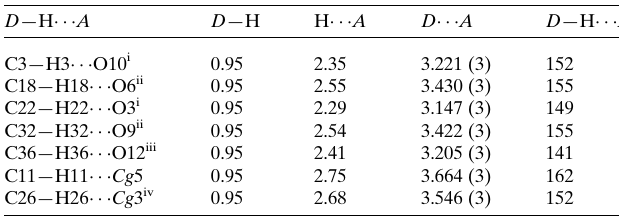
Table 1 Hydrogen-bond geometry (A˚ , (cid:2) ).